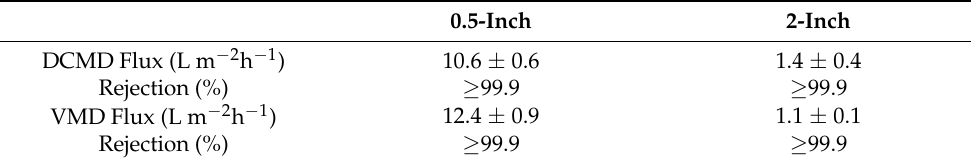
Table 4. DCMD and VMD performance of 0.5-inch and 2-inch modules consisting of PVDF TBHF membranes prepared from 50 kg batches. Tests were carried out in out-to-in mode using 35 g L − 1 NaCl as the feed and DI water as the permeate-side liquid in